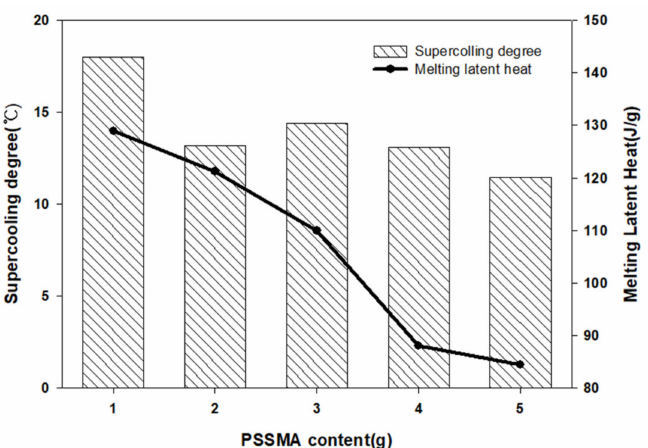
Figure 4. Supercooling temperatures and melting latent heats obtained upon variation in the PSSMA